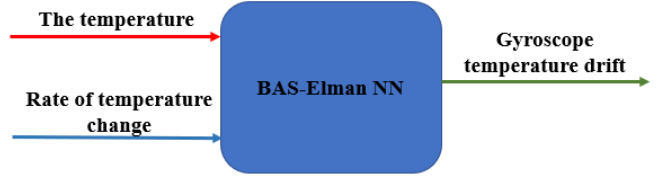
Figure 4. Temperature compensation model framework.